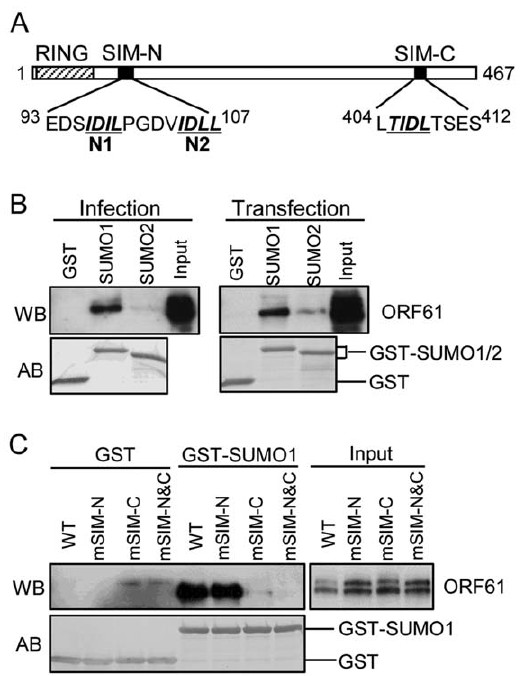
Figure 1. ORF61 binds to SUMO1/2 through conserved SUMO- interacting motifs (SIMs). (A) Schematic representation of the ORF61 protein sequence (amino acids 1-467). The diagonal shaded box indicates the RING domain; filled boxes indicate the three conserved SIMs; the sequences of the SIM hydrophobic core are highlighted by italics and underlined. The numbers in superscript show the amino acid positions of the SIMs in ORF61. (B) Binding of ORF61 (from VZV-infected or ORF61-transfected cell lysates) to SUMO1/2 in GST pull down. Western blot with ORF61 antibody shows the ORF61 proteins bound to SUMO1/2; amido black (AB) staining shows the amount of GST and GST- SUMO1/2 proteins used for binding. (C) Binding of ORF61 SIM mutant proteins from transfected cell lysates to SUMO1 in GST pull down. Western blot shows the amount of ORF61 or SIM mutant proteins bound to SUMO1 and the amount of proteins in the input lysates; amido black (AB) staining shows amount of GST and GST-SUMO1 proteins used for